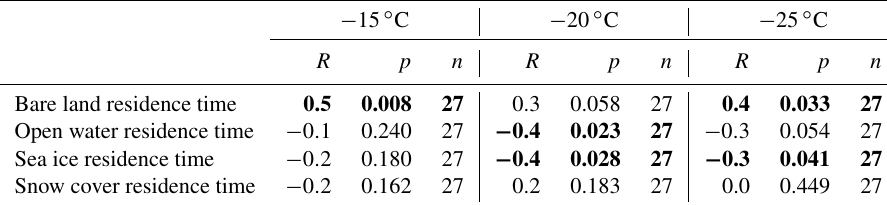
Table 1. Correlation coefficients ( R ), p values, and n values for correlation analysis between [INP( T )] (L − 1 ) at − 15, − 20, and − 25 ◦ C; and the time the air mass spent in the previous 7 days over different surface types within 0–300m of the surface. Numbers in bold indicate correlations that are statistically significant ( p < 0 .